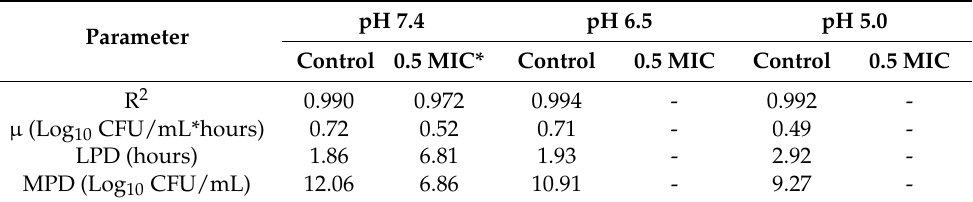
Table 5. Mean of the parameters estimated by the Gompertz model for the wild-type strains at pH 7.4, 6.5, and 5.0.